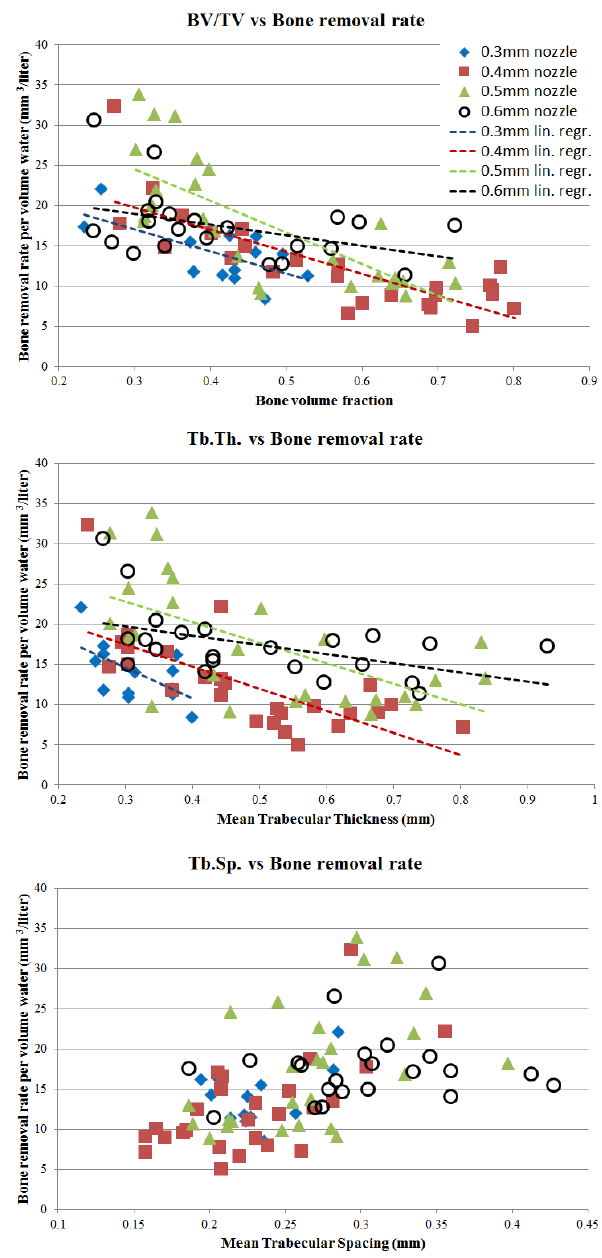
Figure 4. The influence of the nozzle diameter, BV/TV, Tb.Th. and Tb.Sp. on the VRR. The dashed lines represent the outcomes of linear regression analyses for the individual nozzle diameters. The overlap in VRR and regression trend lines indicate an absence of influence of the nozzle diameter on the VRR. No trend lines were depicted in the Tb.Sp. graph due to the lack of significance of the regression analysis for the individual nozzle diameters (Table